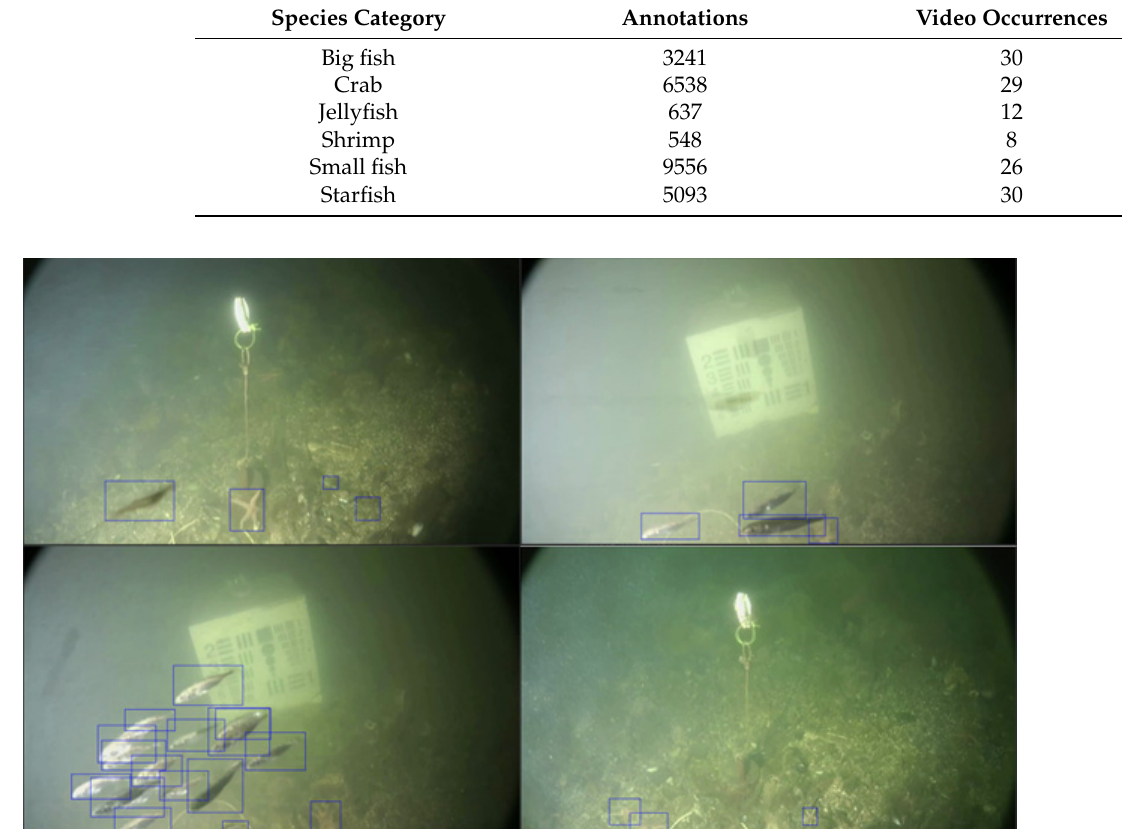
Figure 8. The visual annotations of the brackish dataset.